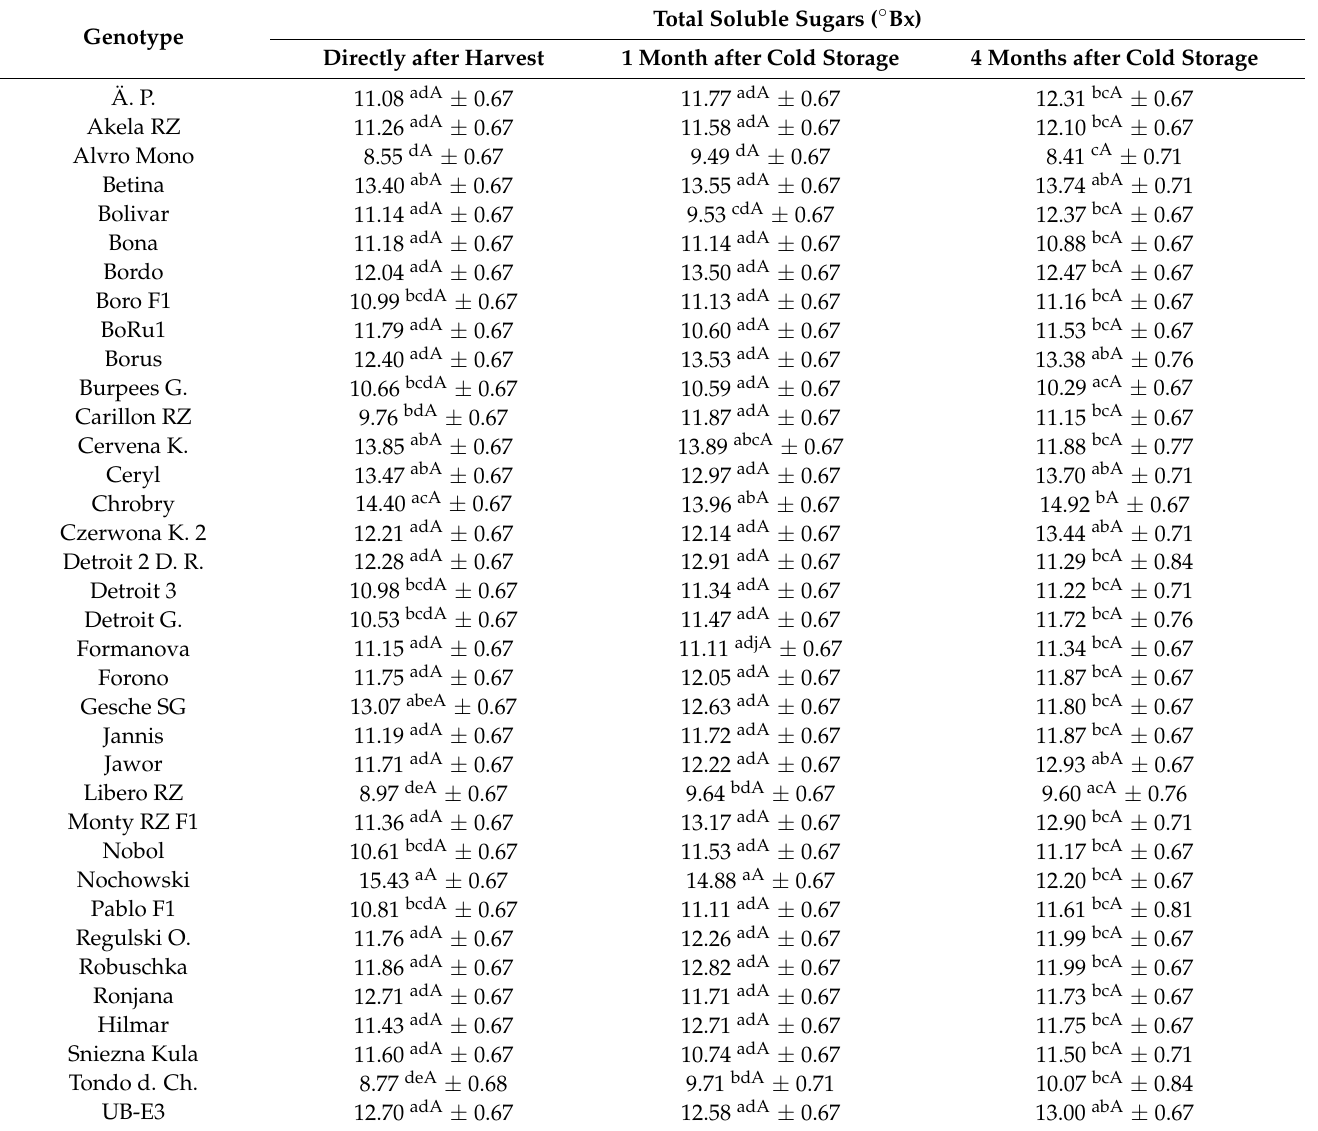
Table 5. Mean values of total soluble sugars ( ◦ Bx) of 36 beetroot genotypes grown at the research station Kleinhohenheim within the years 2017 and 2018, directly after harvest, and after the cold storage periods of one and four months. Results represent the mean values ± standard error. Means followed by at least one identical lower-case letter in one column did not differ significantly between genotypes at experiment-wise Type 1 error α = 0.05. Means followed by at least one identical upper-case letter in one row did not differ significantly between storage periods at experiment-wise Type 1 error α =